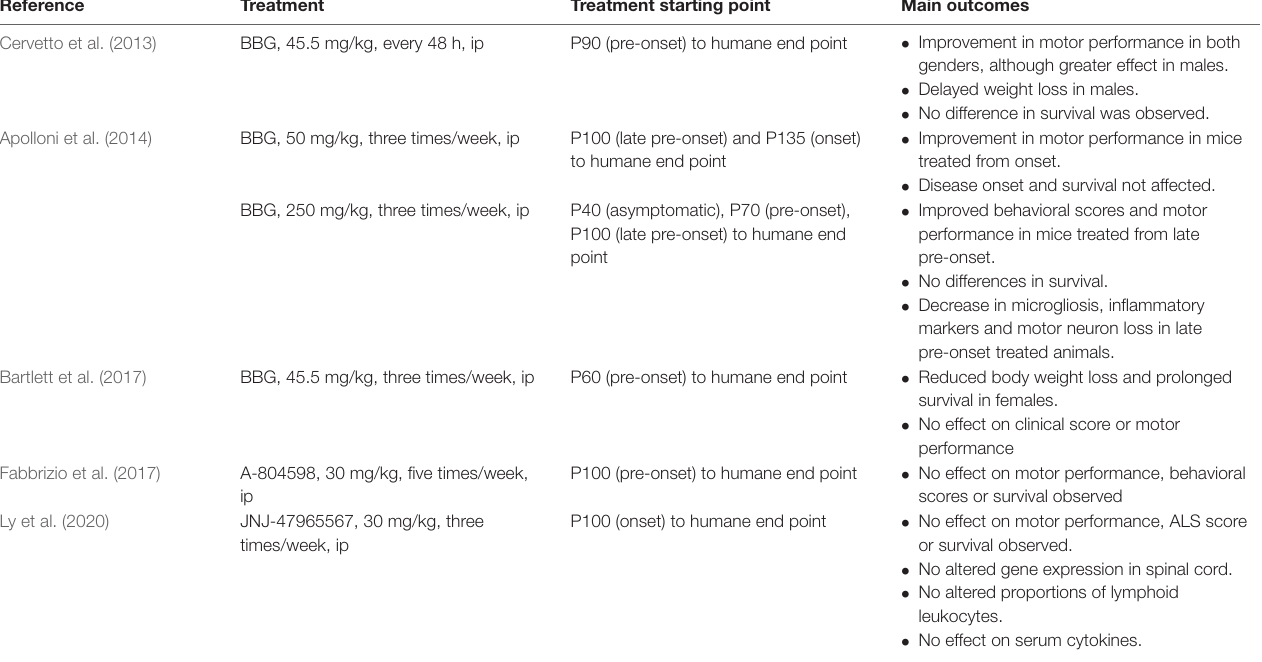
TABLE 1 | Proof of concept of P2X7R antagonism on clinical outcomes in SOD1 G93A mice.